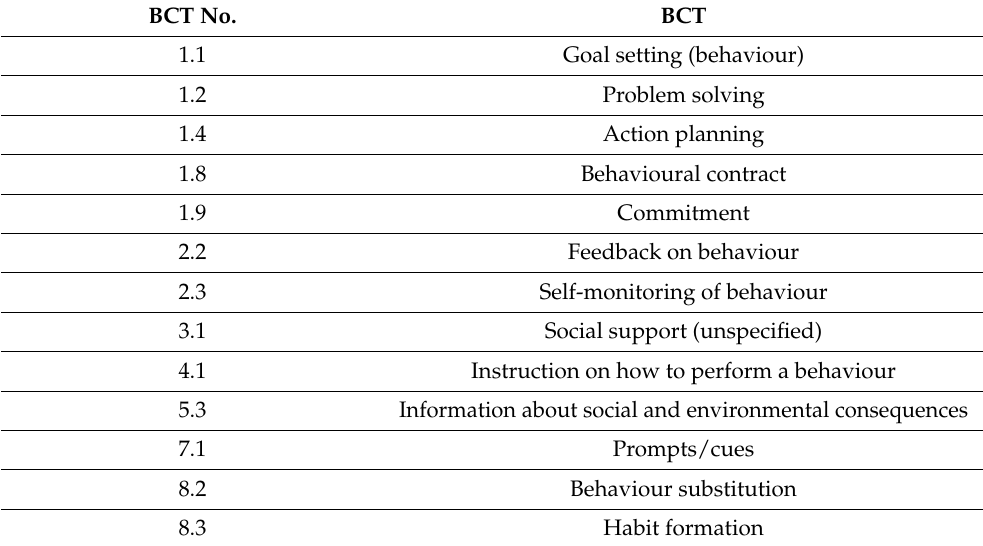
Table 3. BCTs used from Michie’s v1 Taxonomy (BCT ** is ‘increase positive emotions’, which is a new BCT scheduled for inclusion in future iterations of the taxonomy